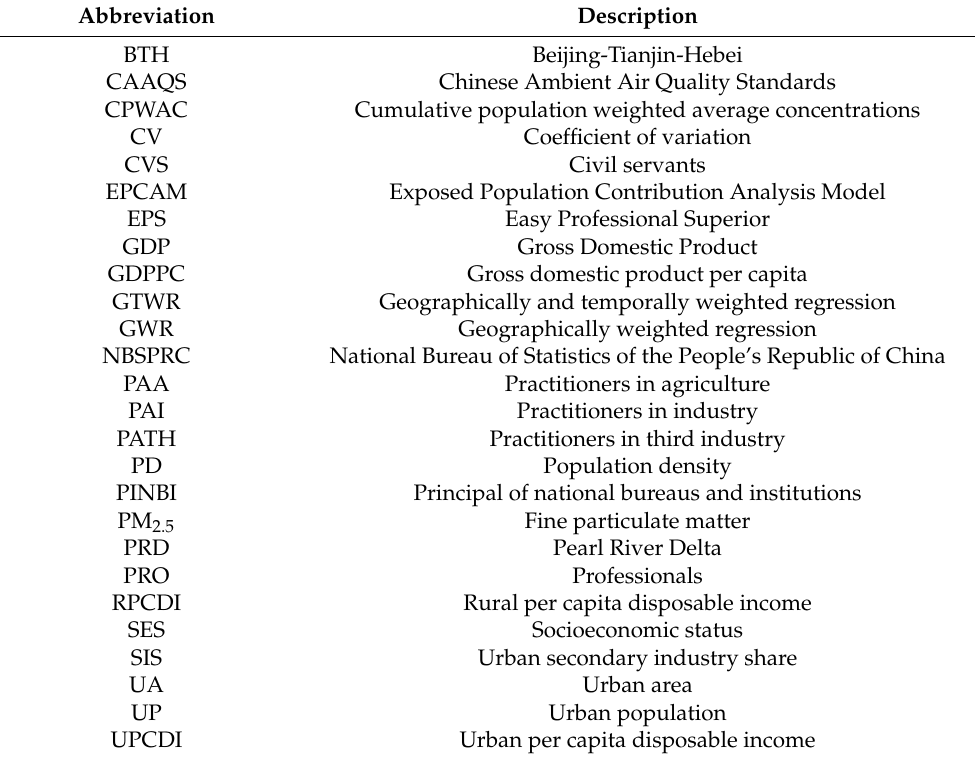
Table A3. List of